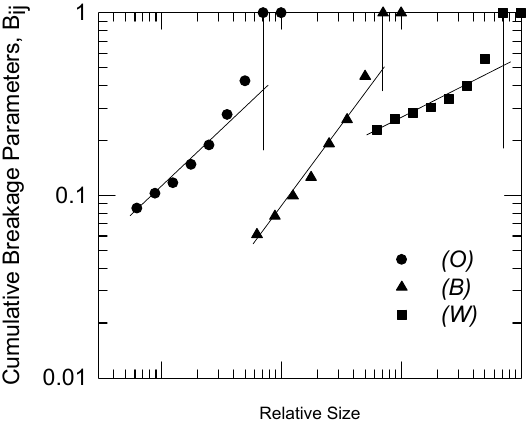
Figure 5. Cumulative breakage distribution for the 16 × 20 mesh materials ( O ), ( B ) and ( W ) . Table 4. Parameters of primary breakage distribution by BII method.